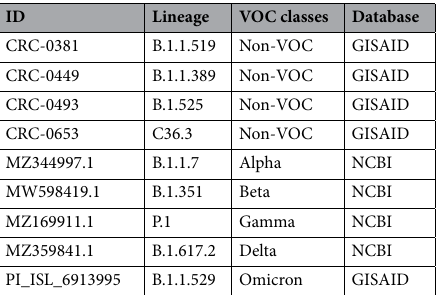
Samples Expected genotype Predicted